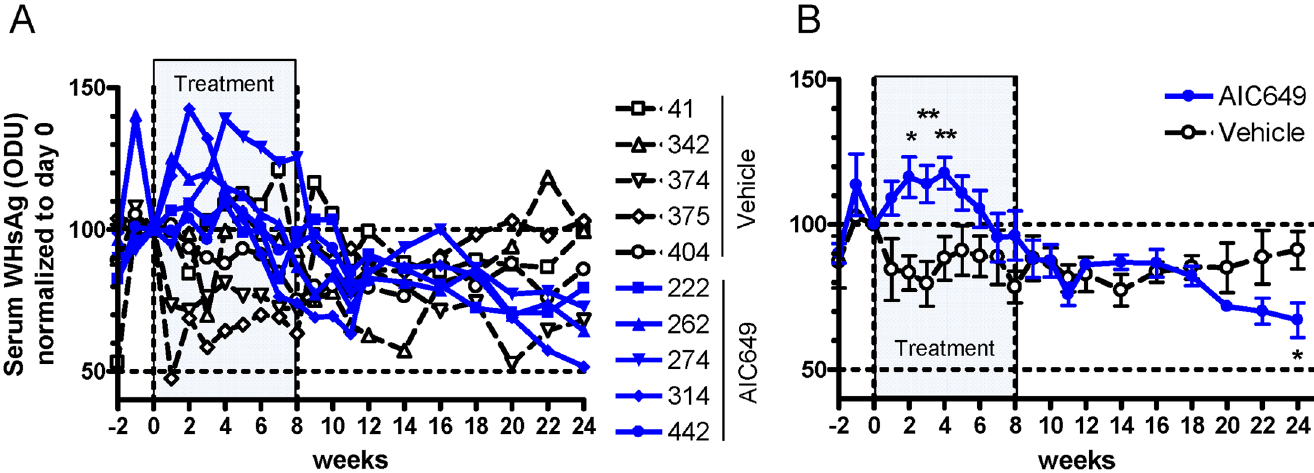
Fig 4. AIC649 induces a bi-phasic treatment effect on antigenemia levels in chronic WHV carrier woodchucks. AIC649 (3.9 x 10 6 Units (ELISA-based titer)) or vehicle were administered i.m. twice weekly for 8 weeks (marked “ Treatment ” ). At the indicated time points woodchucks were bled and serum was subjected to determination of WHsAg load. Values were normalized to individual baseline at day 0 and are given in %. n = 5 / group. Dotted lines: 100% or 50% level. (A) Serum WHsAg concentrations of individual woodchucks (identified by numbers) in the vehicle and AIC649 groups. (B) Group means of WHsAg concentration +/- SEM. * p < 0.05, ** p < 0.01. ODU, optical density units.